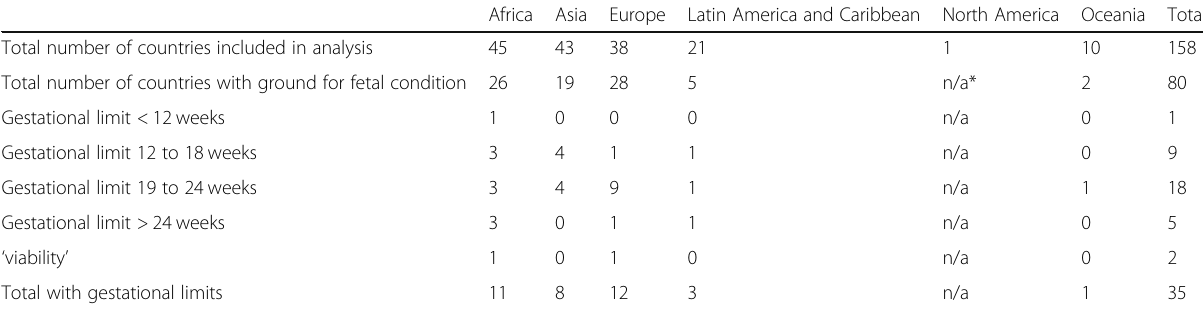
Table 3 Regional data: Ground based on fetal condition and associated gestational